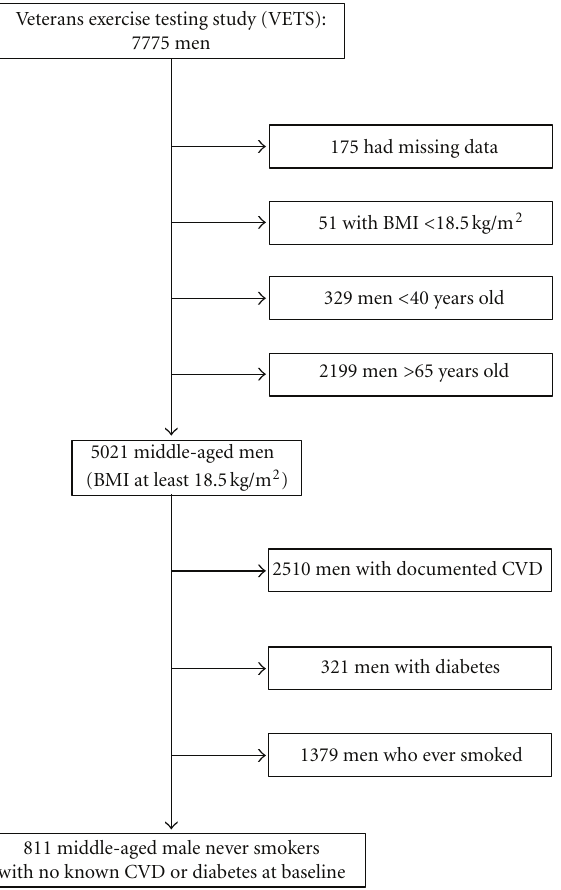
Figure 1: Flowchart of participant